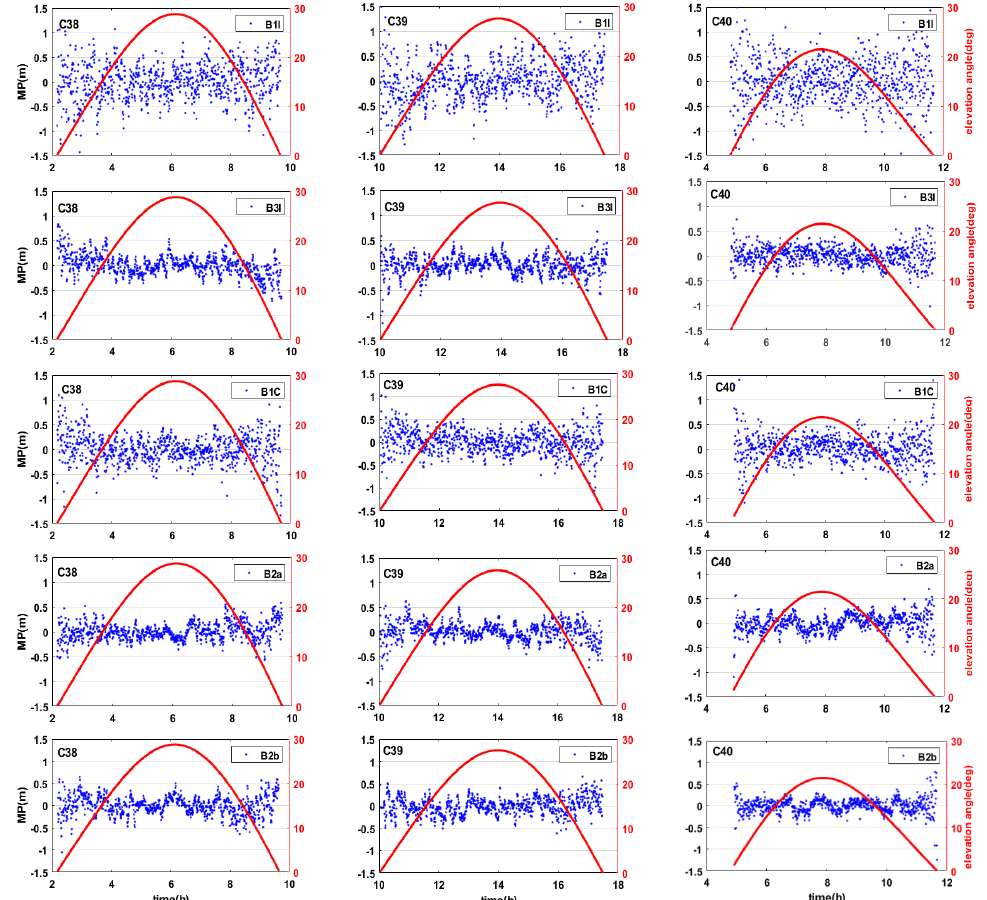
Figure 5. The MP series of BDS-3 IGSO satellites in different frequencies.